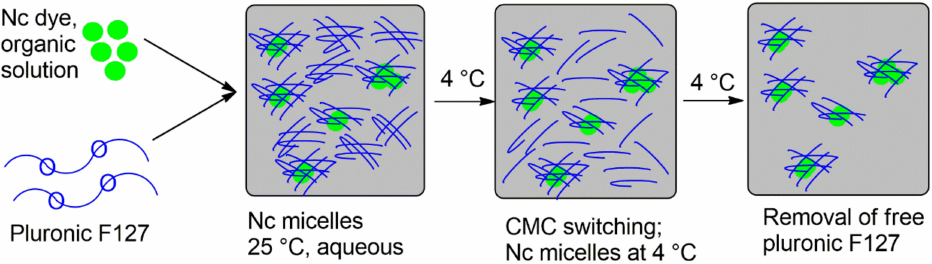
Figure 10. Conceptual representation of frozen micelles preparation using Pluronic